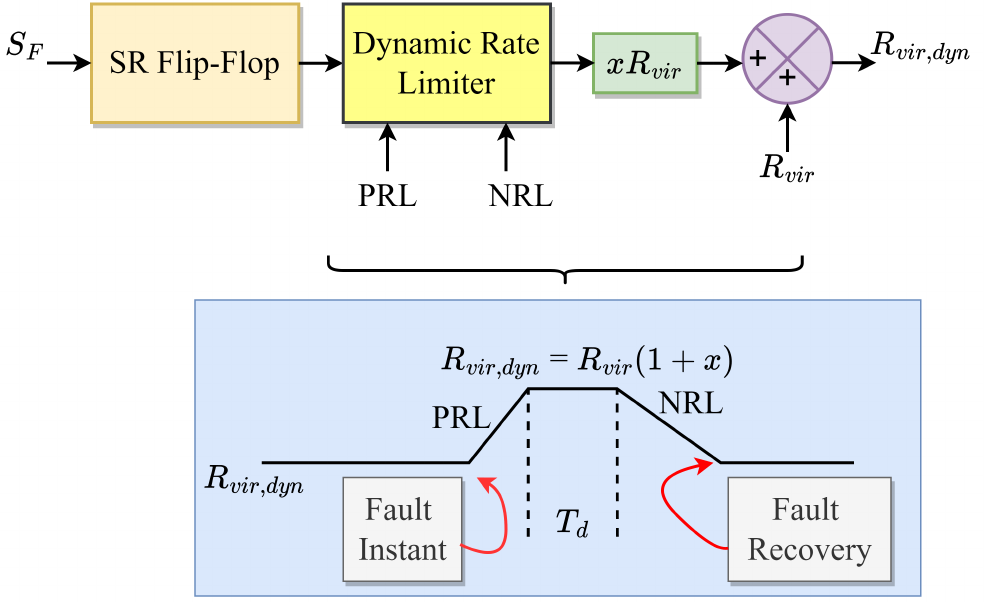
Figure 27. Dynamic damping during fault recovery [126].